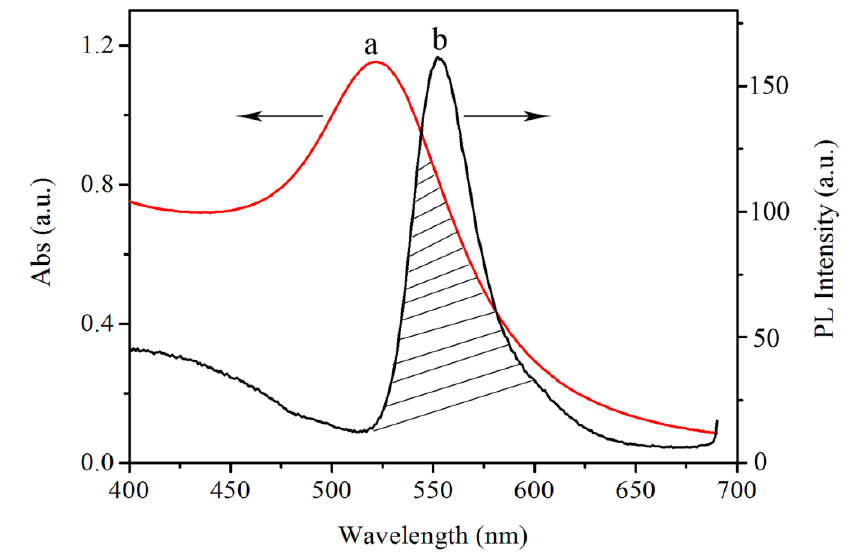
Figure 2. ( a ) Absorption spectrum of AuNPs and ( b ) fluorescence emission of